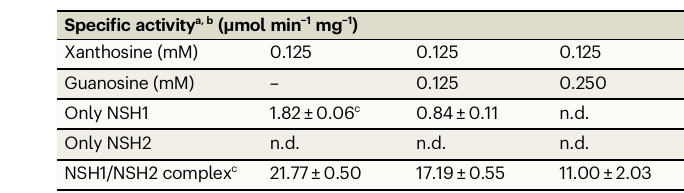
Table 3 | Speci fi c activities of common bean NSH enzymes alone and in